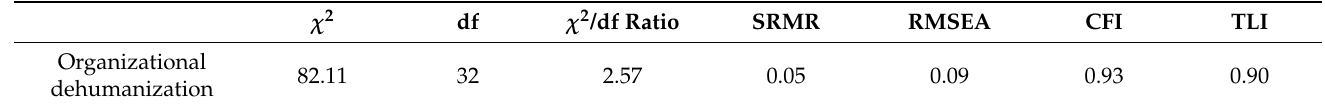
Table 4. Results of the CFA of the Organizational Dehumanization Scale.